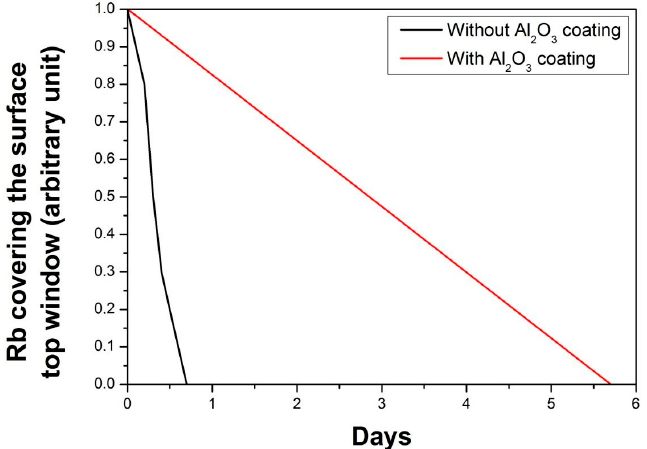
Figure 8. Evolution of the amount of rubidium for two OPMs with and without Al 2 O 3 coating (heated at 150 °C). The measurements were based on the observation of the presence of metallic rubidium on the surface top window of the OPM.